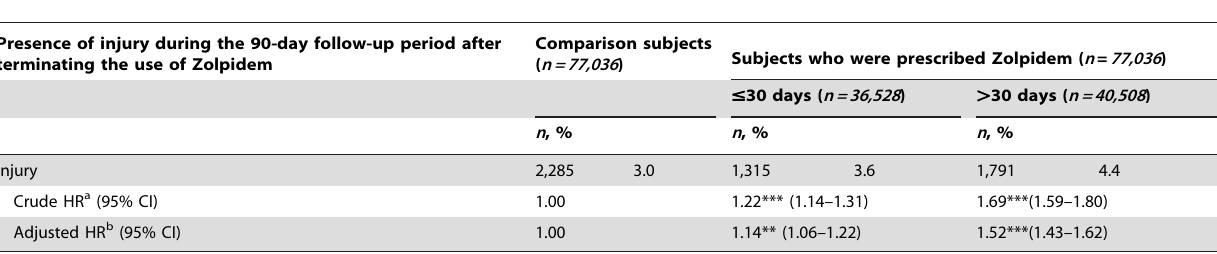
Table 6. Incidence rate, crude and adjusted hazard ratios for injury after terminating the use of Zolpidem among the sampled